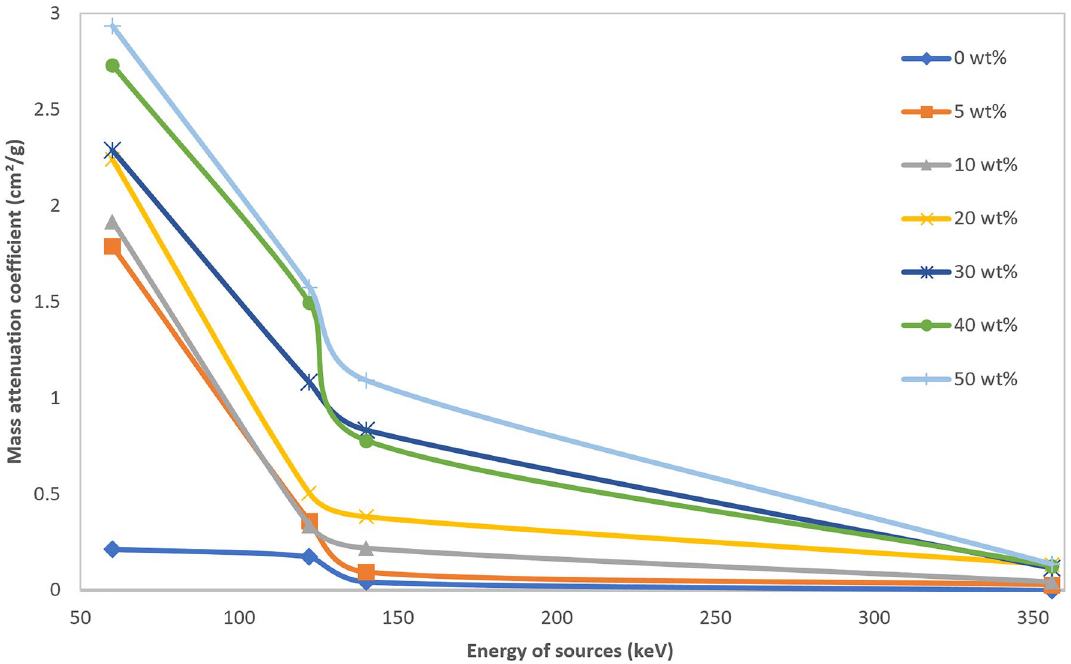
Figure 7. Mass attenuation coefficient of different wt% of PC-Bi 2 O 3 nanocomposite at various energies.